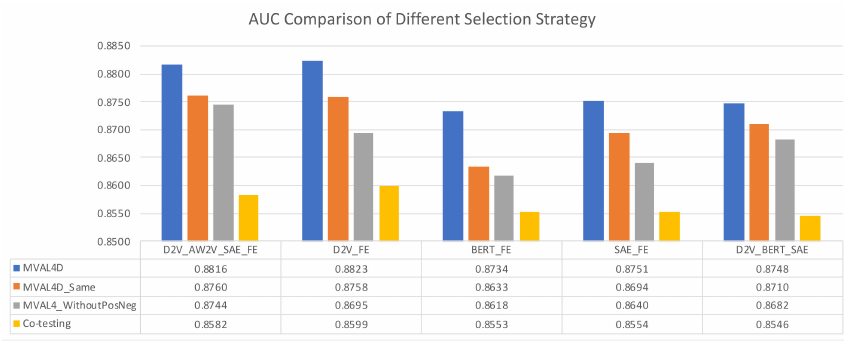
Figure 5. Accuracy comparison of different selection strategies.